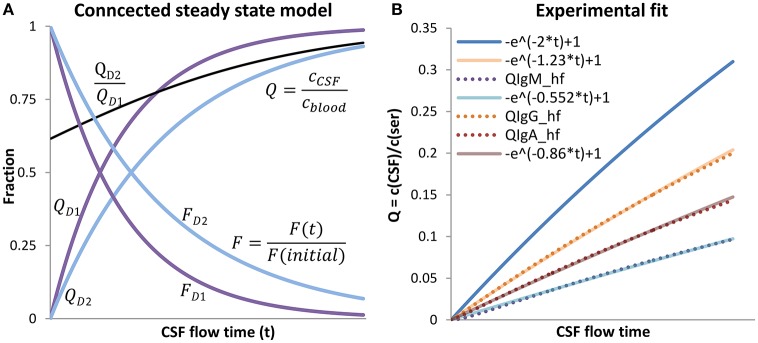
The connected steady state model. (A) The steady state model is shown for two different substances D1 and D2. For the faster diffusing molecule, D1, the resulting ͽ¯ was set to 2 and for D2 to 1.23, k/L was set to 1. T was left variable and interpreted as CSF flow time (x-axis). QD1/2 are drawn with Equation (10), FD1/2 with Equation (11). The black line is the gradient QD2QD1 with the characteristic that QD2QD1→1 when t → ∞. The concentration in CSF, relative to the blood concentration  cCSFcblood of the slower diffusing substance D2, increases more slowly in CSF. With longer CSF flow times, the “molecular flux,” relative to the maximal rate F(t)F(initial), decreases faster for the faster diffusing substance D1 than compared to the slower diffusing substance D2, this is because of the faster increasing back-diffusion rate from CSF to blood of the faster diffusing substance D1. As a consequence, the gradient QD2QD1 (black line) between the faster (D1) and the slower diffusing substance (D2) increases constantly toward 1; the different impression by observing QD1 to QD2 is caused by the scaling. The proportion of D1 to D2 equates to the fitted relationships of QAlb to QIgG in (B). (B) Shows the experimental fit for the three immunoglobulins. QAlb is defined as QAlb. The experimental data representing curves QIgG/−A/M-hf were calculated using Equation (12) with the appropriate parameters for IgG/-A/-M (Table 1) The connected steady state equations were then manually fitted to the experimental data with Equation (13), by adjusting the ratio ͽIgX¯ͽALB¯.